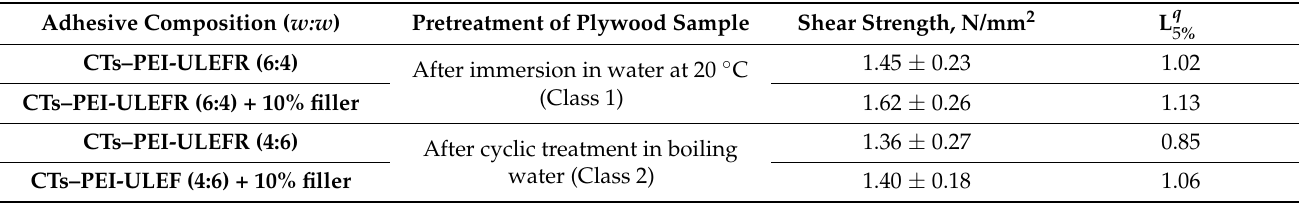
Table 5. Influence of grey alder bark extraction residues applied as an additive to the adhesive system, on the mechanical properties of plywood.